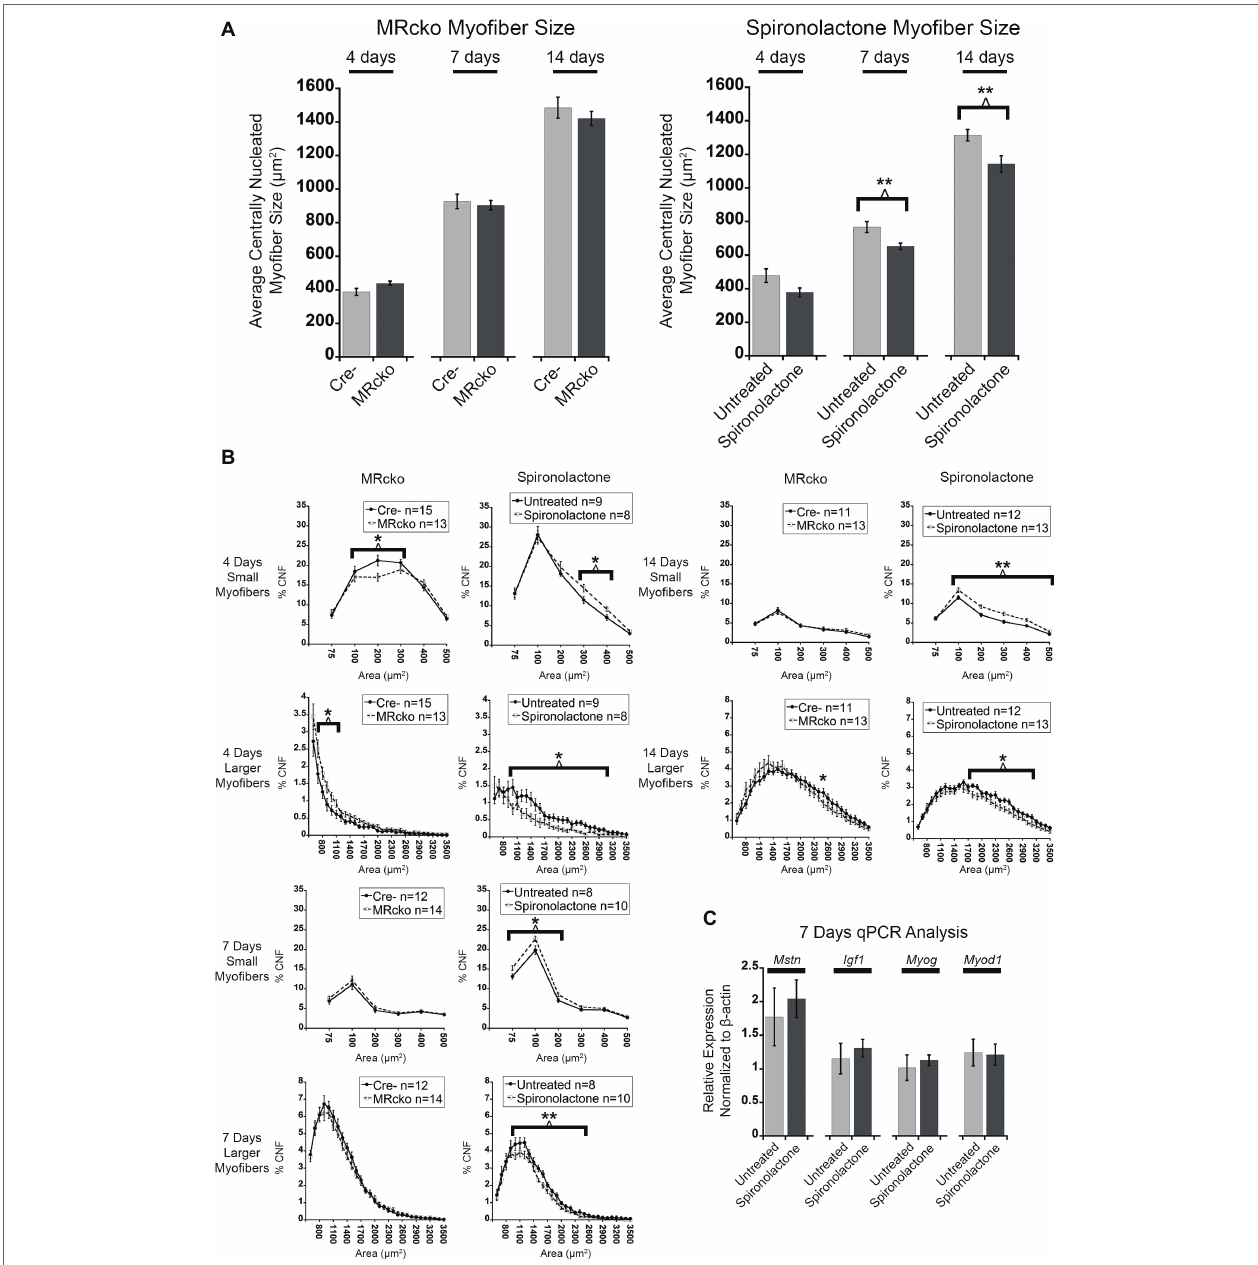
FIGURE 4 | MR antagonism reduces myofiber size after acute muscle injury. (A) Bar graphs showing the average size of centrally nucleated tibialis anterior myofibers at 4 ( n = 15 Cre − , and 13 MRcko) ( n = 9 untreated, and 8 spironolactone), 7 ( n = 12 Cre − , and 14 MRcko) ( n = 8 untreated, and 10 spironolactone), and 14 ( n = 11 Cre − , and 13 MRcko) ( n = 12 untreated, and 13 spironolactone) days post-injury in MRcko versus Cre − mouse littermates (left panel) and MR antagonist-treated and untreated wild-type littermate mice (right panel). The data are presented as mean ± SEM. ** p ≤ 0.01. (B) The distribution of centrally nucleated myofiber percentages was broken down by size in line graphs into small myofibers 75–600 μ m 2 and larger myofibers 600–3,600 μ m 2 . The centrally nucleated myofiber size was analyzed at 4 ( n = 15 Cre − , and 13 MRcko) ( n = 9 untreated, and 8 spironolactone), 7 ( n = 12 Cre − , and 14 MRcko) ( n = 8 untreated, and 10 spironolactone), and 14 ( n = 11 Cre − , and 13 MRcko) ( n = 12 untreated, and 13 spironolactone) days post-injury. For size analysis, the following numbers of centrally nucleated myofibers were analyzed for each group and days post-injury: 2,653 ± 105 Cre − and 2,584 ± 161 MRcko at 4 days post-injury, 2,810 ± 166 Cre − and 2,818 ± 181 MRcko at 7 days post-injury, 3,103 ± 157 Cre − and 3,173 ± 193 MRcko at 14 days post-injury, 2,466 ± 167 untreated and 2,697 ± 167 spironolactone treated at 4 days post-injury, 2,465 ± 165 untreated and 2,629 ± 130 spironolactone treated at 7 days post-injury, and 2,730 ± 159 untreated and 3,019 ± 157 spironolactone treated at 14 days post-injury. (C) Bar graph showing representative myogenic factor and myofiber growth genes assessed in spironolactone treated ( n = 5) and untreated ( n = 5) littermates at 7 days post-injury. Beta-actin levels are used as a normalization control for each sample and fold- changes are normalized to the same untreated control. Mstn , myostatin; Igf1 , insulin-like growth factor 1; Myog , myogenin; Myod1 , myoblast determination protein 1. The data are presented as mean ± SEM. All data were analyzed using a Student’s t -test, * p ≤ 0.05 and ** p ≤ 0.01 for the bins of fiber-sizes shown by the